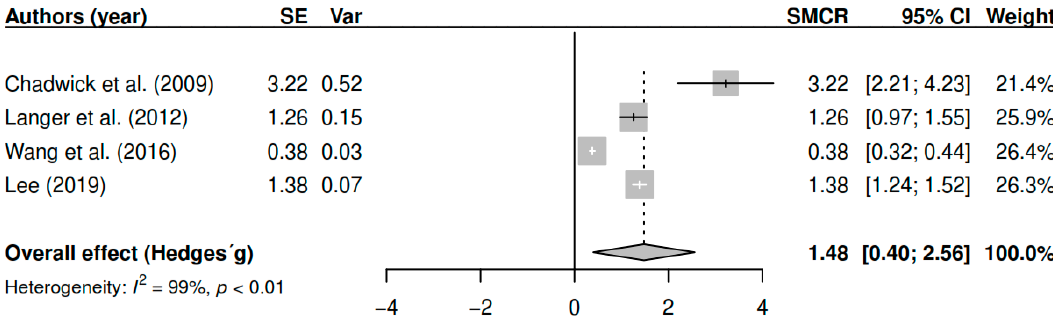
Figure 7. Forest plot for the model of random-effects and the values of Hedges’ g statistics in the functioning variable (pretest–posttest).